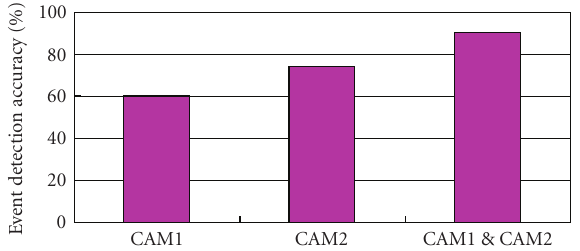
Figure 6: Event detection classification results based on sin- gle/multiple